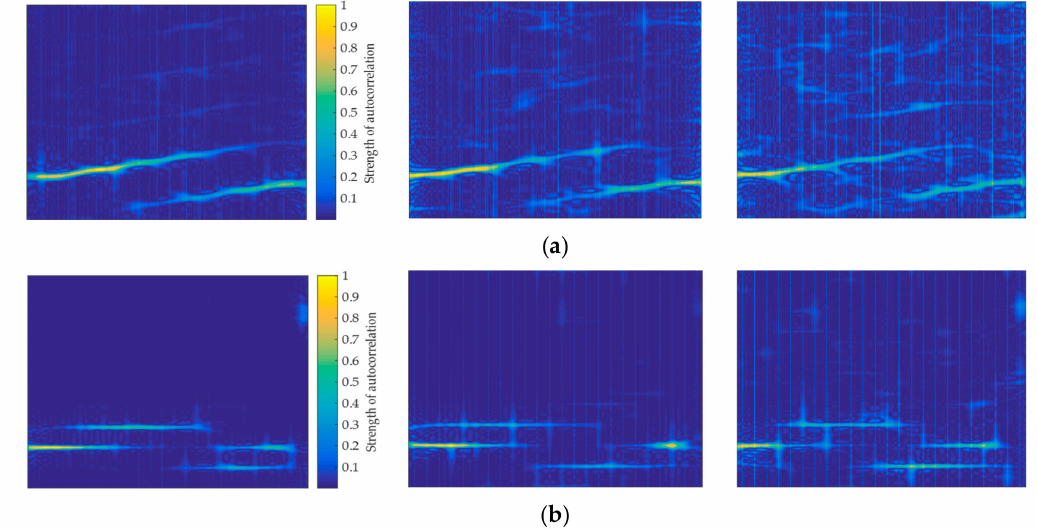
Figure 4. Feature images formed from left to right when SNR is 3 dB, 0 dB, and − 3 dB, respectively: ( a ) Unprocessed signal TFI of Frank; and, ( b ) Short-time autocorrelation feature Image of